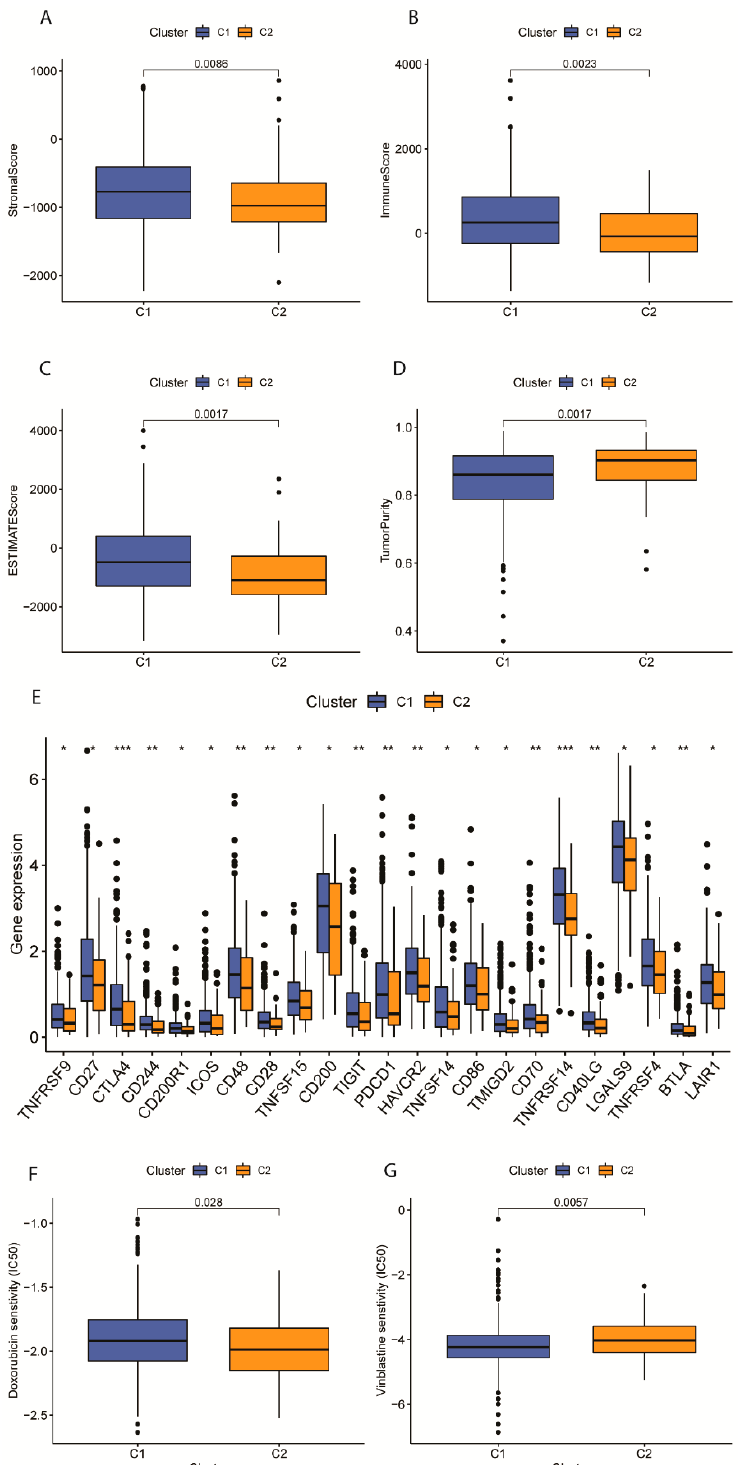
Figure 8. Tumor immune microenvironment analysis and drug sensitivity test for EC molecular subtypes. ( A – D ) Patterns of stromal cell scores, immune cell scores, ESTIMATE scores, and tumor purity between subtypes C1 and C2 of EC. ( E ) Expression profiles of 23 immune checkpoints between EC molecular subtypes. * means p < 0.05, ** means p < 0.01, *** means p < 0.001. ( F ) Box plot displaying the estimated IC50 values for Doxorubicin from the two molecular subtypes. ( G ) Box plot displaying the estimated IC50 values for Vinblastine from the two molecular